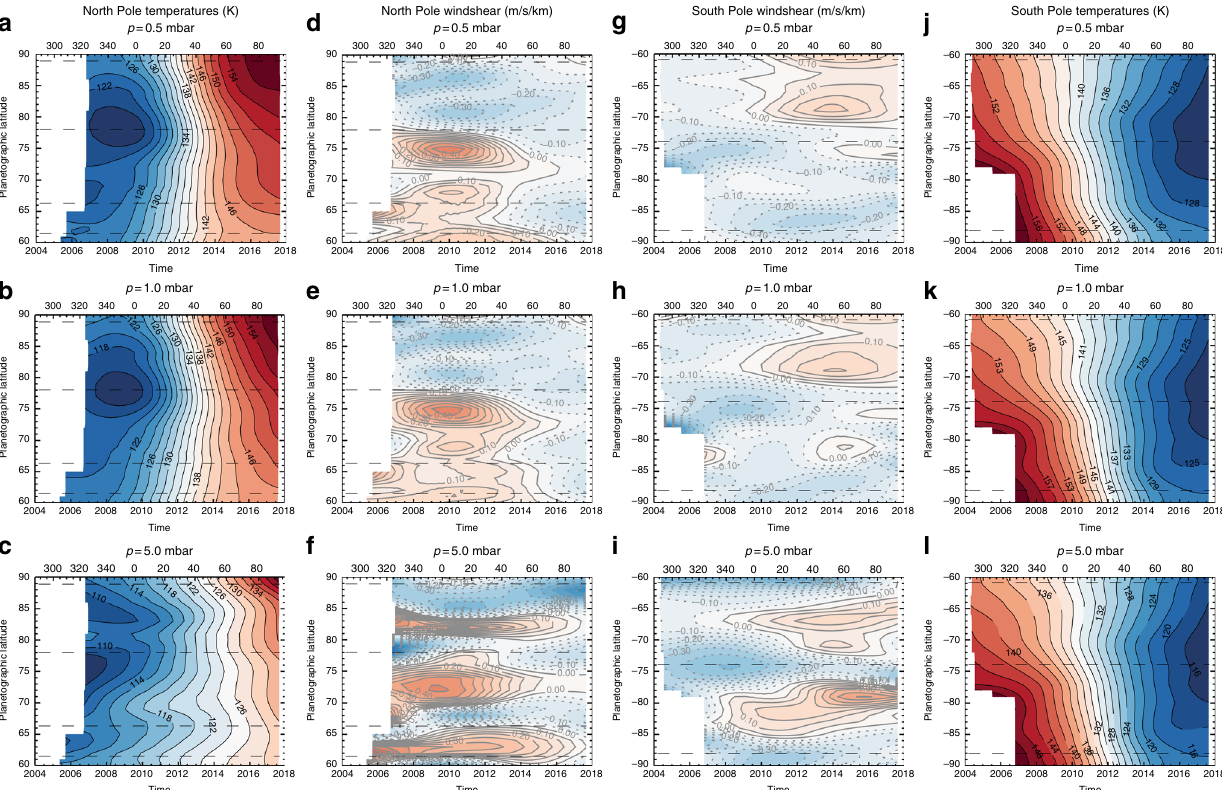
Fig. 4 North and South polar stratospheric temperature gradients as a function of time throughout the whole Cassini mission, 2004 – 2017. We display north polar temperatures ( a – c ), north polar windshears ( d – f ), south polar windshears ( g – i ) and south polar temperatures ( j – l ) at three different pressure levels (0.5, 1.0 and 5.0 mbar). These were derived from averages of low-resolution CIRS spectra on a monthly temporal grid and interpolated using tensioned splines 43 to reconstruct a smoothed temperature fi eld. Horizontal dashed lines signify the peak of eastward zonal jets in the troposphere 9 . The data are displayed as a function of time (years), but a second horizontal axis provides the planetocentric solar longitude ( L s ) in